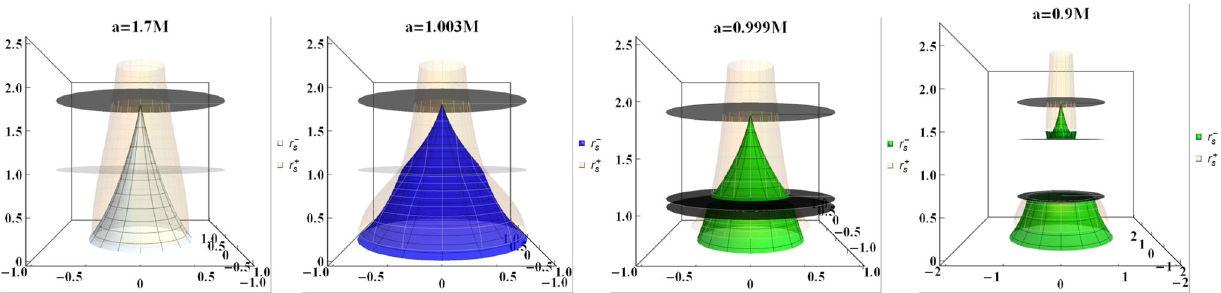
Fig. 3 Plots of the surfaces r ± s (in units of mass) versus the frequency ω for different spin values a / M , including BH and NS geometries. The surfaces r ± s are represented as revolution surfaces with height r ± s ( ver- tical axes ) and radius ω (horizontal plane). Surfaces are generated by